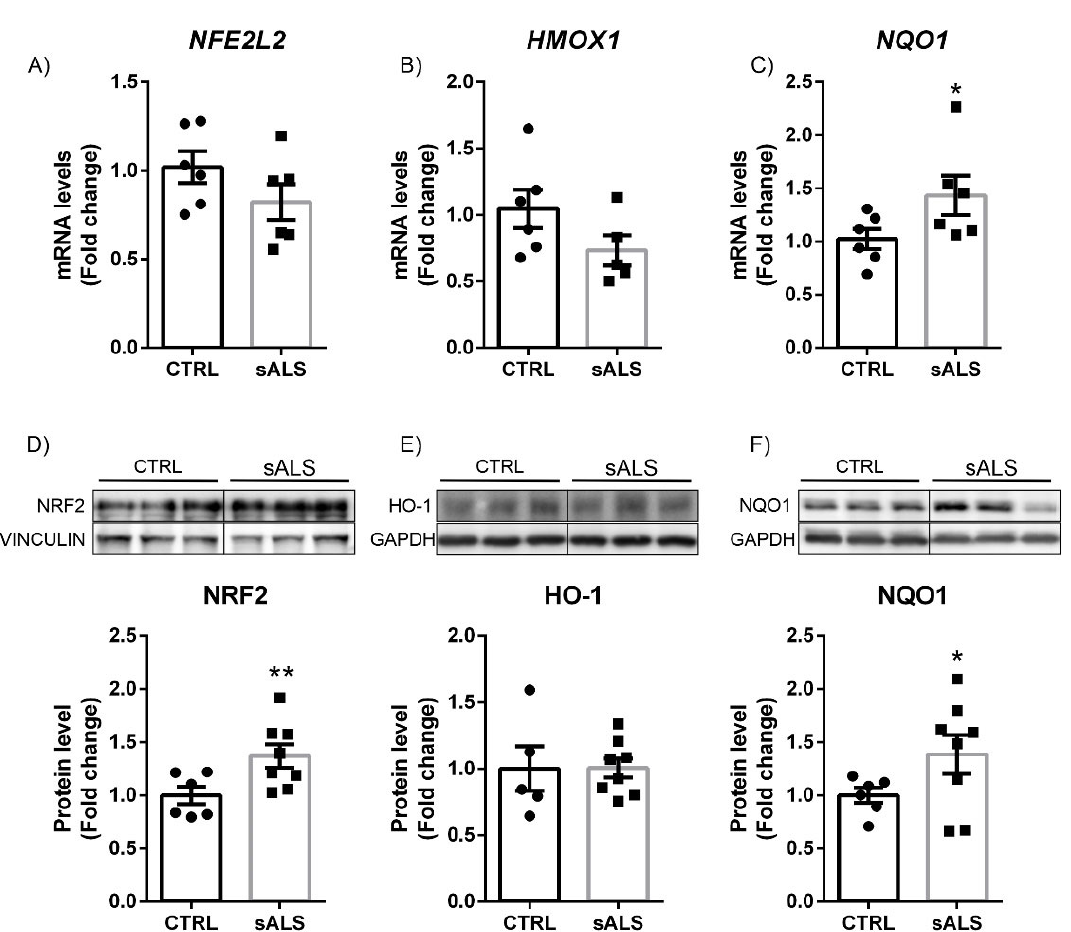
Figure 4. Increased NRF2 and NQO1 protein levels in the motor cortex in sALS patients. Quantitative real-time PCR determination of mRNA levels of ( A ) NFE2L2 , ( B ) HMOX1, and ( C ) NQO1. All genes were normalized by TBP (TATA box binding protein) mRNA levels; n = 6 samples ± SEM. Asterisks denote significant differences at * p < 0.05 when comparing sALS to control patients according to the Student’s t -test. Protein levels of ( D ) NRF2, ( E ) HO-1, and ( F ) NQO1 were analyzed by immunoblotting and their respective protein quantifications; n = 6–8 samples per experimental group ± SEM. Asterisks show significant differences at * p < 0.05 and ** p < 0.001 when comparing groups according to the Student’s t ‐ test.